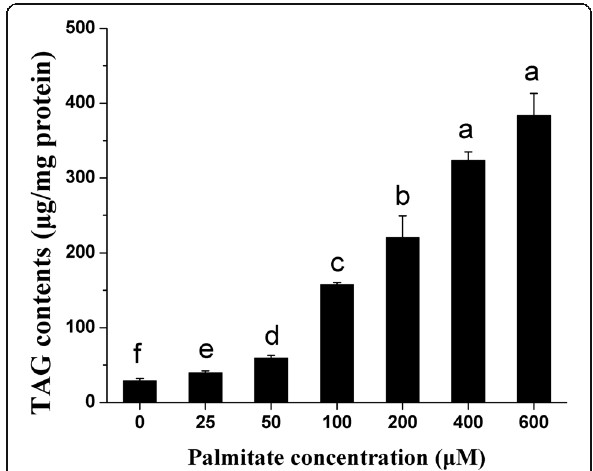
Fig. 2 Effect of palmitate on cellular TAG content in pMECs. pMECs were incubated for 24 h with different concentrations of palmitate (0 (control), 25, 50, 100, 200, 400, and 600 μ M). The data are expressed as the mean ± SEM ( n = 6). Different letters indicate statistical significance between different concentrations of palmitate treatment groups ( p <